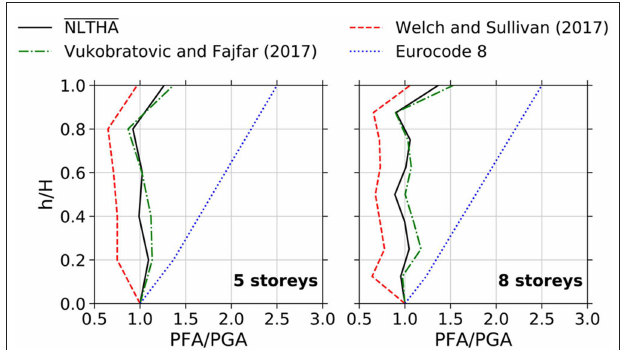
FIGURE 10 | Example of PFA comparisons between mean response-history analyses and estimation procedures (with targeted inelastic ductility demands µ = 2, archetypes of building config. 1).